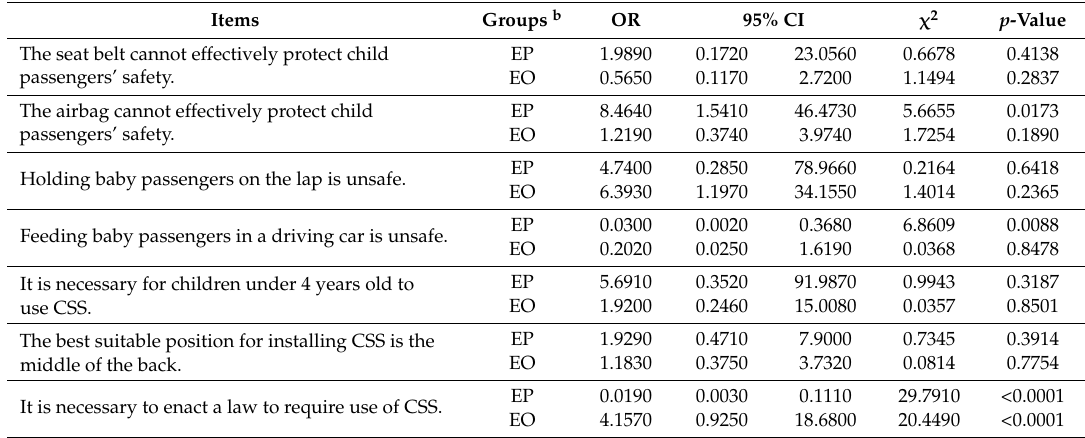
Table 4. The results of binomial logistic regression on knowledge and behaviors a . Items Groups b OR 95% CI χ 2 p